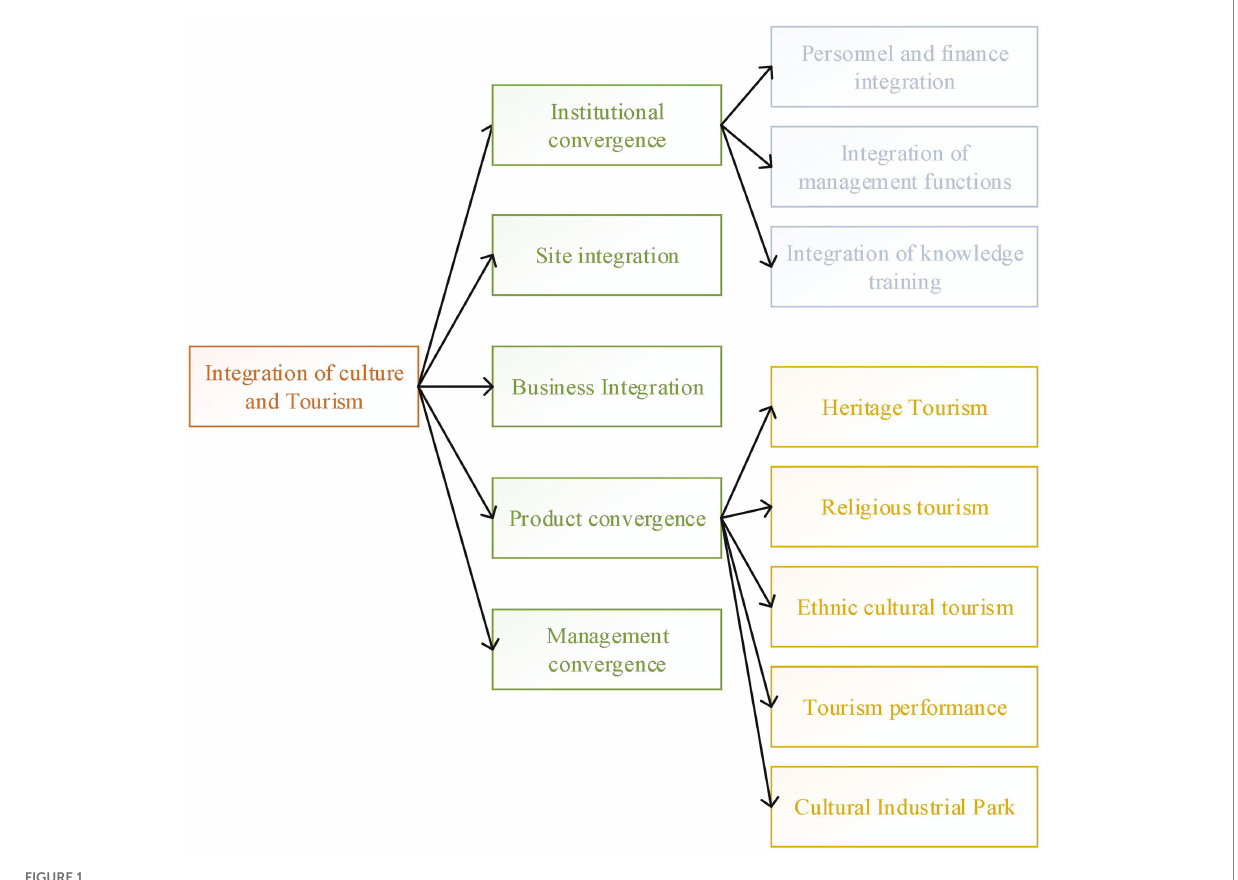
FIGURE 1 The way of integration of culture and